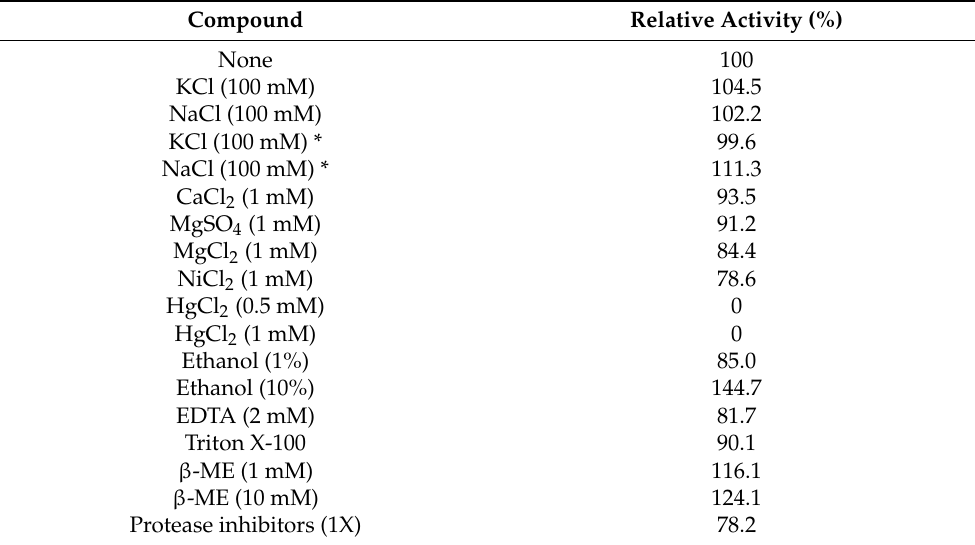
Table 2. Influence of different compounds on F-ALDH